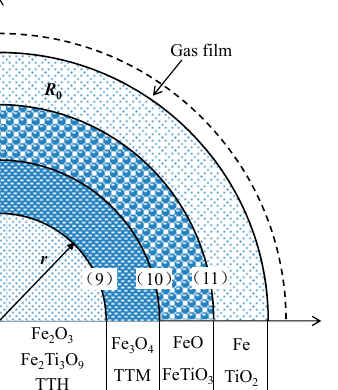
Figure 15. Schematic diagram of the interface progressions for the gas-based reduction of the HCVTM pellets.